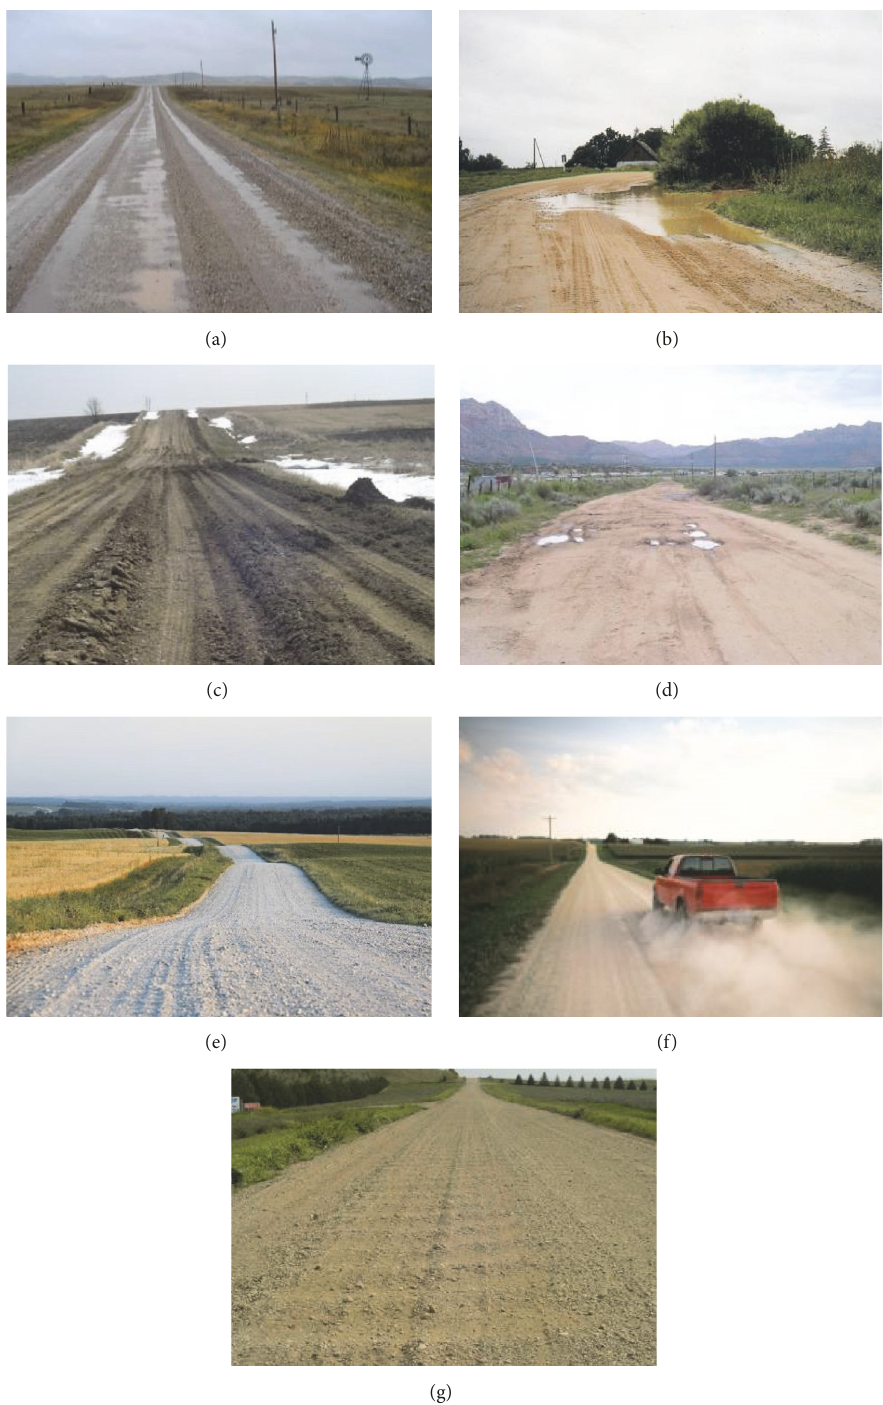
Figure 1: Distresses of unpaved roads: (a) X-section, (b) roadside drainage, (c) rutting, (d) potholes, (e) loose aggregate, (f) dust, and (g) corrugations. Source: